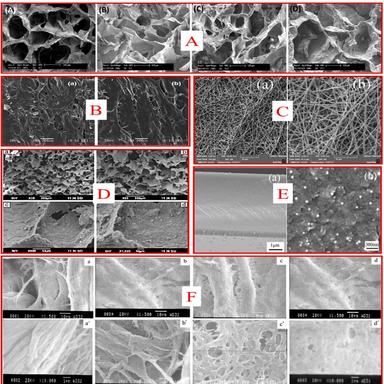
Scanning Electron Microscopic (SEM) images, (A). Composites of (A) Chitosan-Gelatin, (B) Nano-hydroxyapatite/ chitosan–pectin / Chitosan-Gelatin (10 wt %), (C) Nano-hydroxyapatite/chitosan–pectin / Chitosan-Gelatin (30 wt%), and (D) Nano-hydroxyapatite/ chitosan – pectin / Chitosan-Gelatin (50 wt%), (B). Macroporous structures of pectin/ carboxymethyl cellulose / microfibrillated cellulose porous (a) Cellulose (0%) and (b) Cellulose (0.1%), (C) Electrospun Nanofiber membrane of P